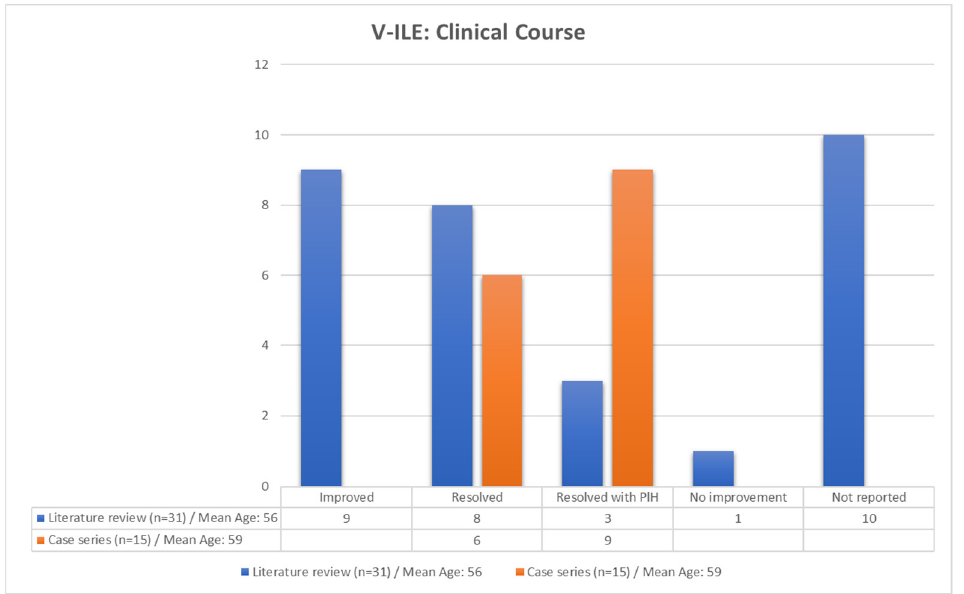
Figure 18. Clinical course of cases in the case series and the literature review. n = number of cases; PIH, post inflammatory hyperpigmentation.